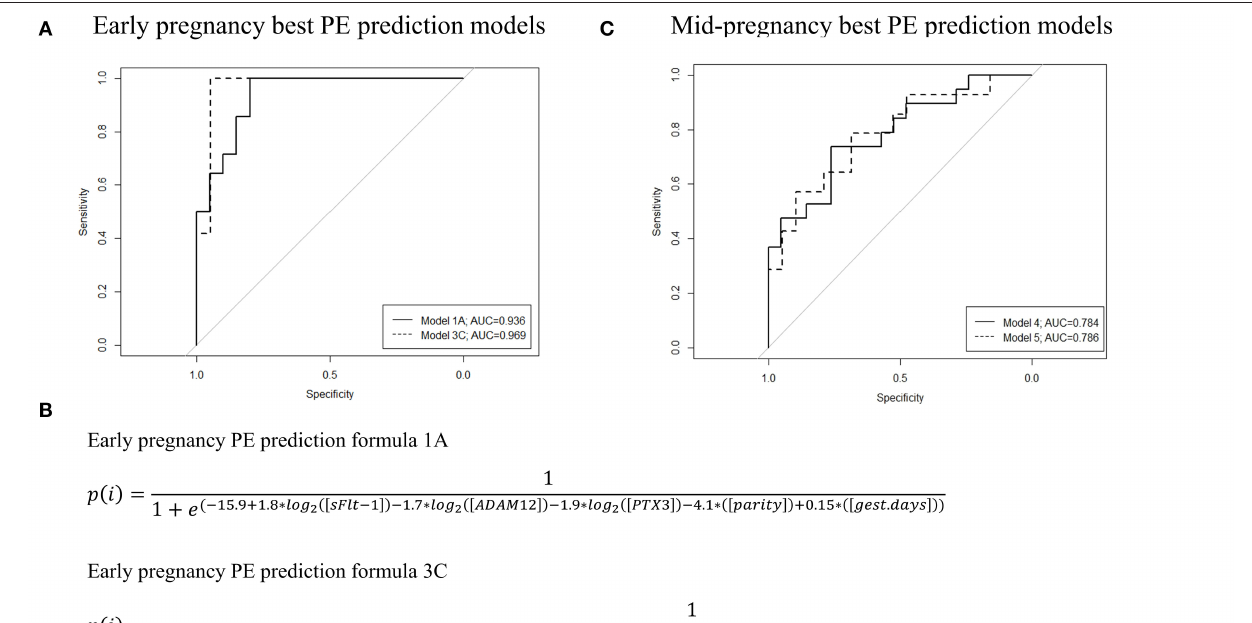
FIGURE 3 | ROC curves, AUC values, and the formulas of the best performing preeclampsia (PE) prediction models were developed based on the Luminex ® 6PLEX assay data. The best PE prediction models are based on the analysis of serum samples collected during either (A) 70th-98th or (C) 100th − 182nd g days . Early pregnancy model 1A incorporated data from three biomarkers (sFlt-1, ADAM12, and PTX3) and model 3C four markers (sFlt-1, sEng, ADAM12, and PTX3), whereas mid-pregnancy models 4 and 5 are based on only PlGF measurements. Model 3C and model 5 additionally included placental genotype data of the FLT1 rs4769613 T/C variant. All models were adjusted for gestational days (gest. days) at sampling and maternal parity (nulliparity or multiparity). (B) PE prediction formulae for models 1A and 3C. Details are presented in Tables 4 , 5 and Supplementary Table S3 . AUC, the area under the curve; ROC, receiver operating